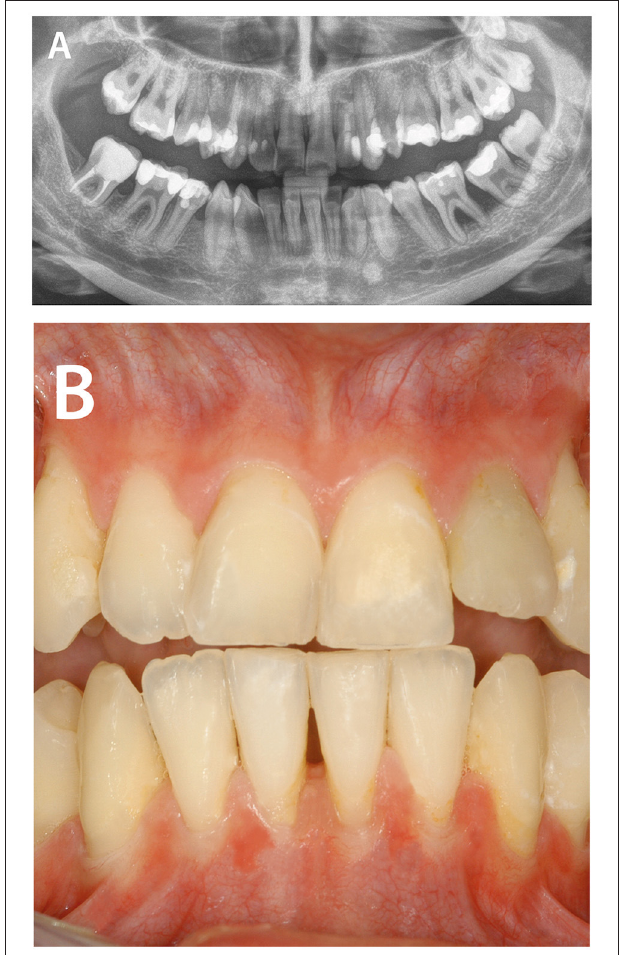
FIGURE 2 | Periodontitis as manifestation of systemic diseases. Periodontal Ehlers-Danlos syndrome is caused by heterozygous mutations in complement 1 subunit genes C1R and C1S leading to hyperactivation of the classical complement pathway. The defining clinical feature is early severe periodontitis diagnosed at a mean age of 14 years. (A) Pattern of alveolar bone loss was described as localized to any region, proceeding in a domino effect from one tooth to the next. (B) The clinician can distinguish periodontal Ehlers-Danlos syndrome from other types of periodontitis by the lack of attached gingiva causing oral tissue fragility and predisposing to severe gingival recession.